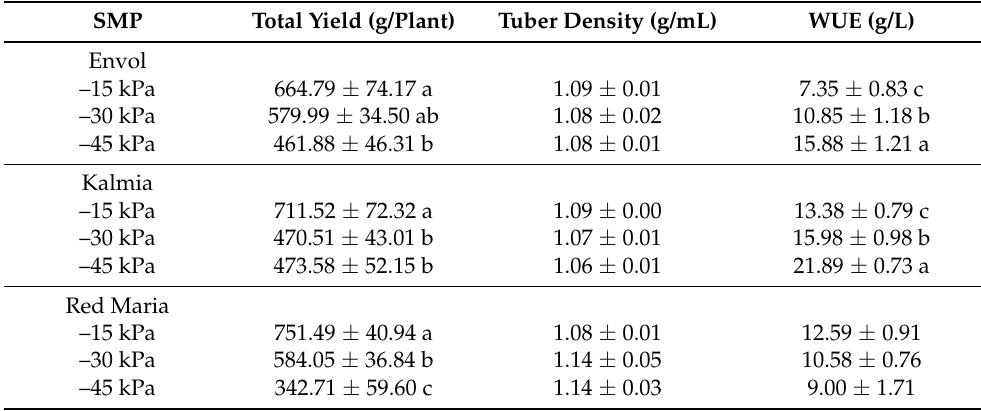
Table 2. Precision irrigation thresholds and variety effects on total tuber yield, tuber density and water use efficiency with the standard error for three potato varieties. The values from the same variety in a column with different letters are significantly different according to the least significant difference (LSD) test. SMP: soil matric potential; WUE: water use